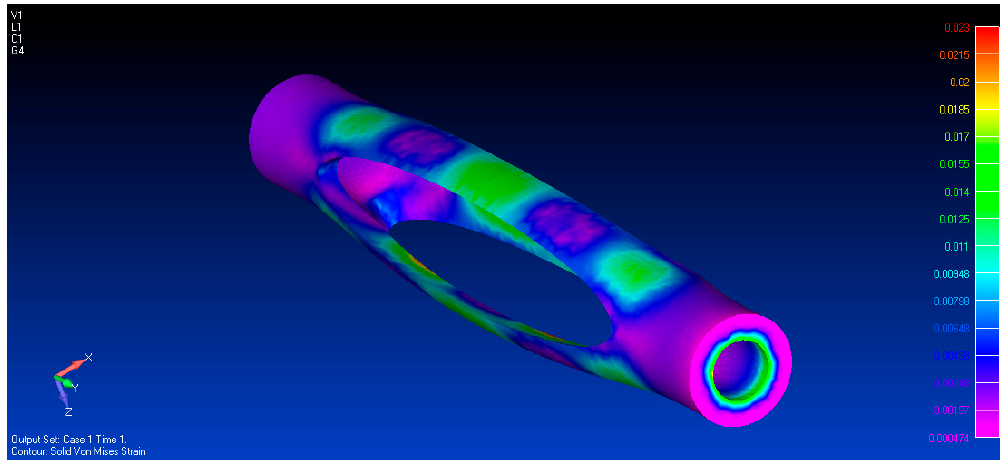
Figure 9. Von Mises strain map: 2 mm transversal displacement, corresponding to a 1 mm axial contraction.